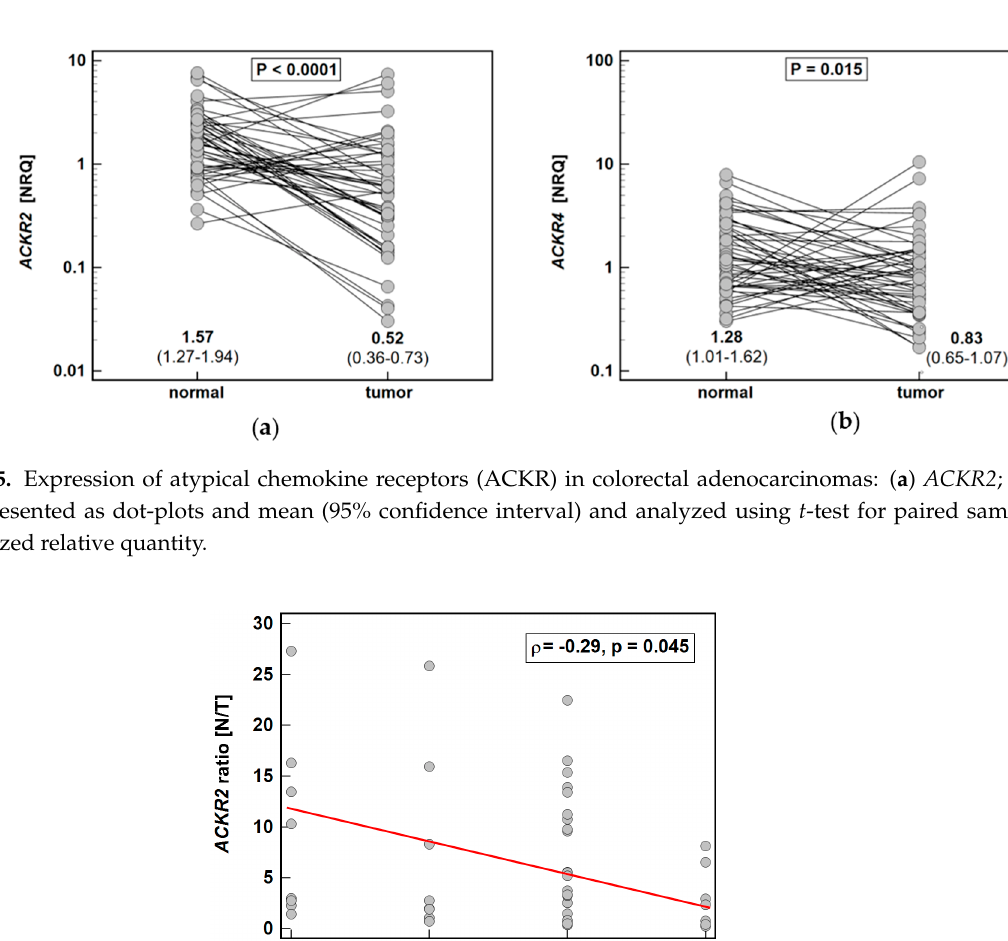
Figure 4. Impact of polyp cumulated risk for malignancy on expression ratio (normal-to-polyp) (N/P) of: ( a ) ACKR2 ; ( b ) ACKR4 . Data presented as means with 95% confidence interval (figures below the dot-plots and red triangles with whiskers) and analyzed using one-way analysis of variance with Students – Newman – Keuls post hoc test. Groups differing significantly in a post hoc analysis are indicated by the same type of symbol: *, #, or ^.